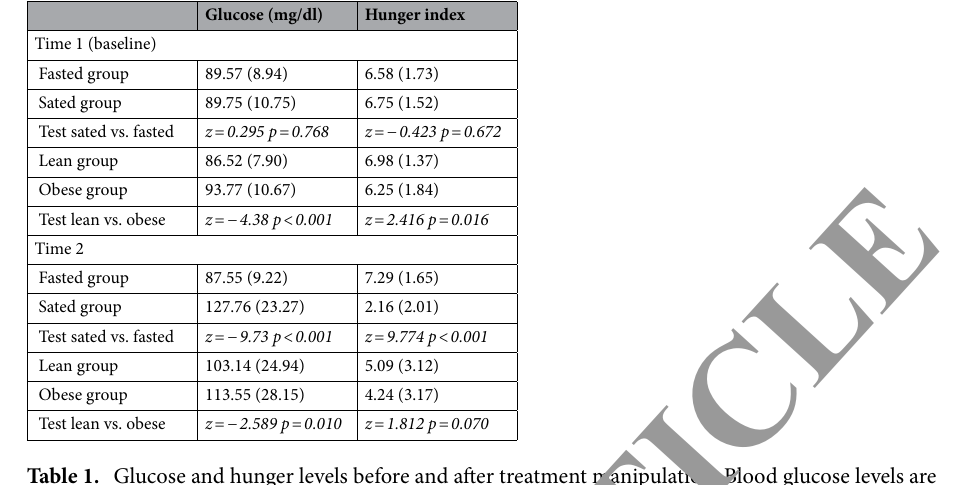
Table 1. Glucose and hunger levels before and after treatment manipulation. Blood glucose levels are expressed in mg/dl. Hunger index range is between 1 and 10. Fasted and Sated refer to between-group treatments. Comparisons between Sated and Fasted, Obese and Lean are two-sided Mann–Whitney rank-sum tests with each individual taken as an independent observation. Standard deviations are in parentheses.